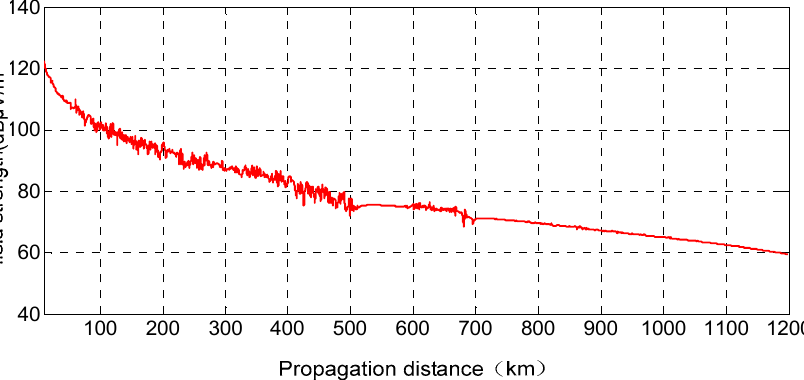
Figure 16. Field intensity propagation curve of the transmitted signal from the southward-oriented antenna.